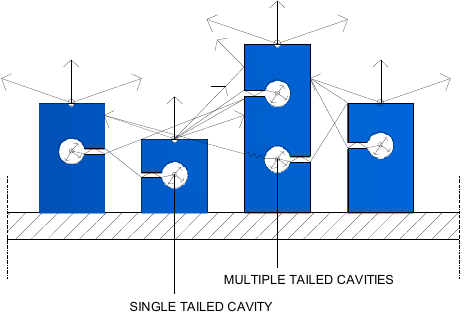
Figure 13. The di ff usivity on the surface design of the panel due to Figure 13. The diffusivity on the surface design of the panel due to reflection.